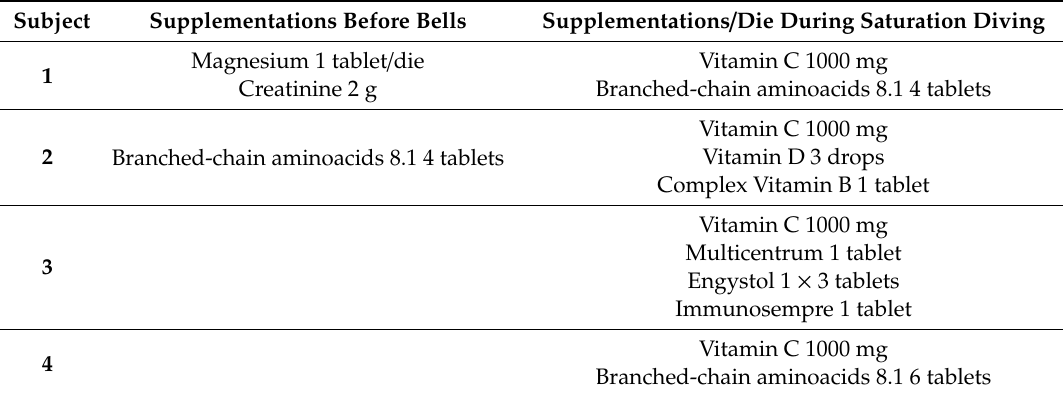
Table 2. Antioxidants supplementation. Daily dosage of supplementation, oral use.